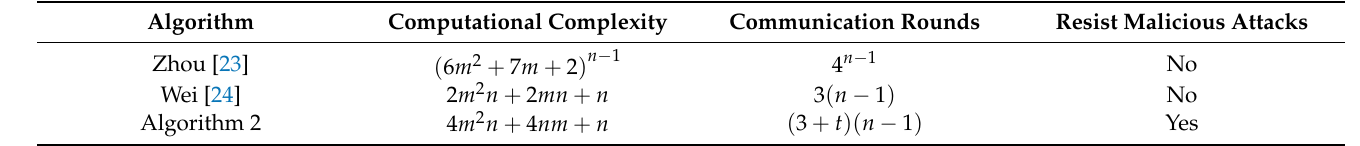
Table 1. Overall performance